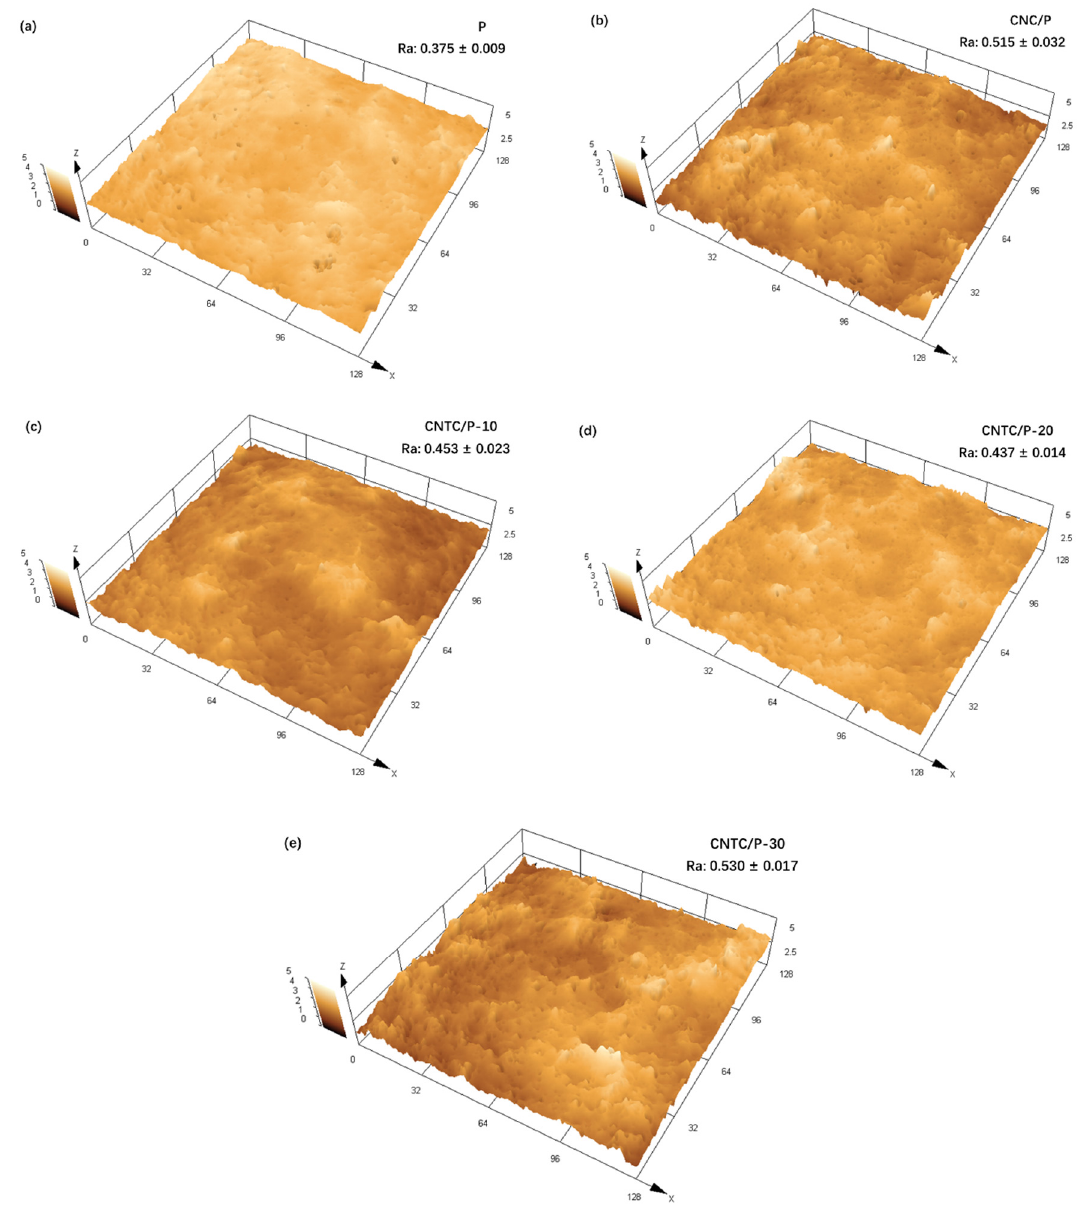
Figure 5. CLSM topography and roughness of the coatings ( a ) Coating P; ( b ) Coating CNC/P; ( c ) Coating CNTC/P-10; ( d ) Coating of CNTC/P-20; ( e ) Coating CNTC/P-30.